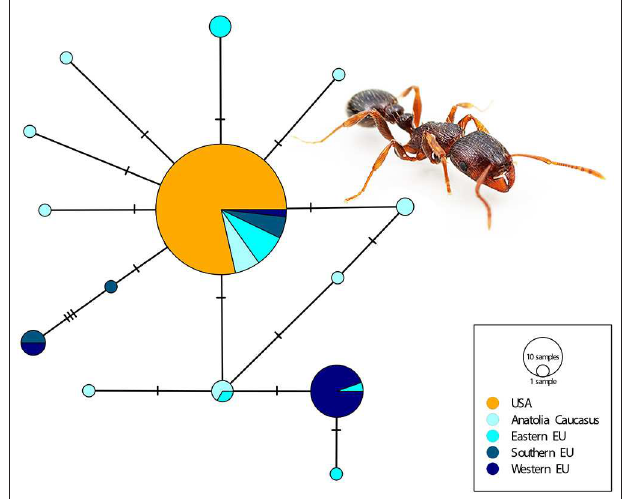
FIGURE 3 | TCS haplotype network of Tetramorium immigrans from the European and North American populations generated using a 348 bp COI fragment, with the following geographic designations: Anatolia/Caucasus (Armenia, Russia, Turkey), Eastern Europe (Bulgaria, Croatia, Czechia, Hungary, Romania), Southern Europe (Greece, Italy, Spain), Western Europe (Austria, France), and USA (Photo: Alex Wild).